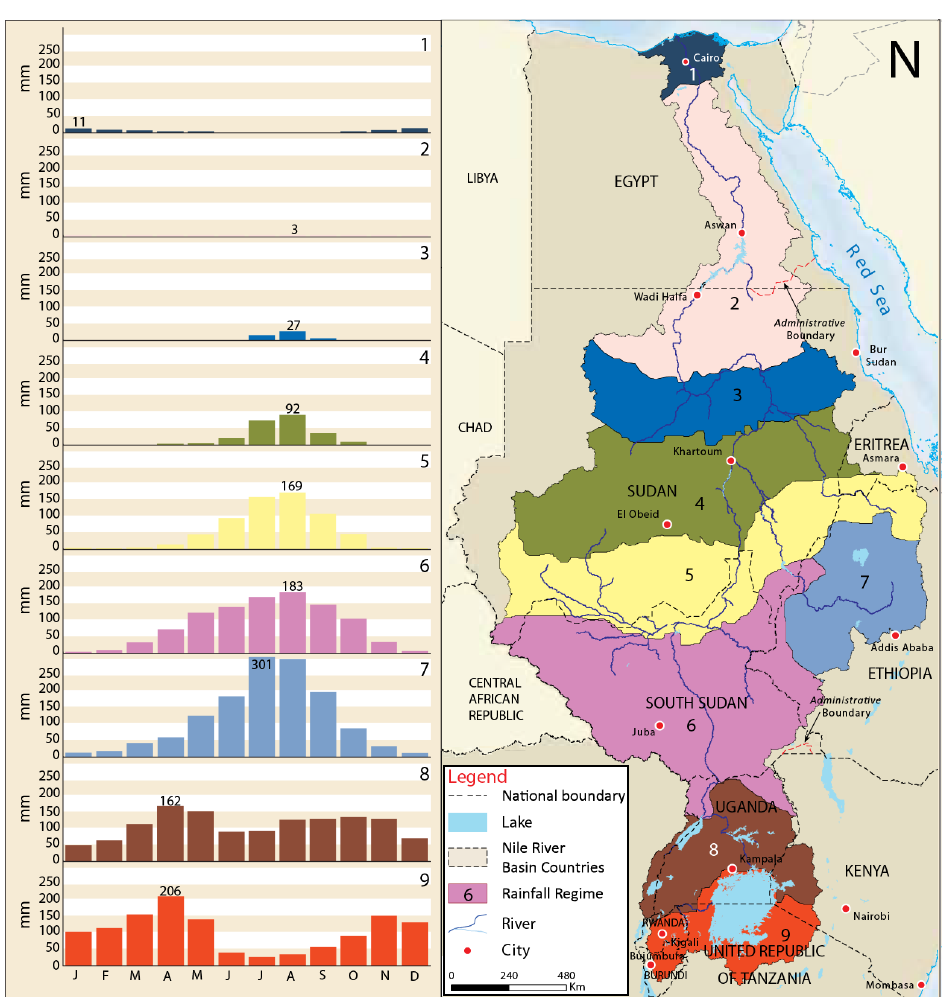
Figure 2. Rainfall regimes over the Nile basin. Base period is from 1961 to 1990. Image modified from [56], data from